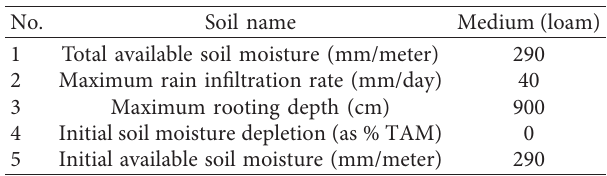
Table 5: Main soil characteristics [37,